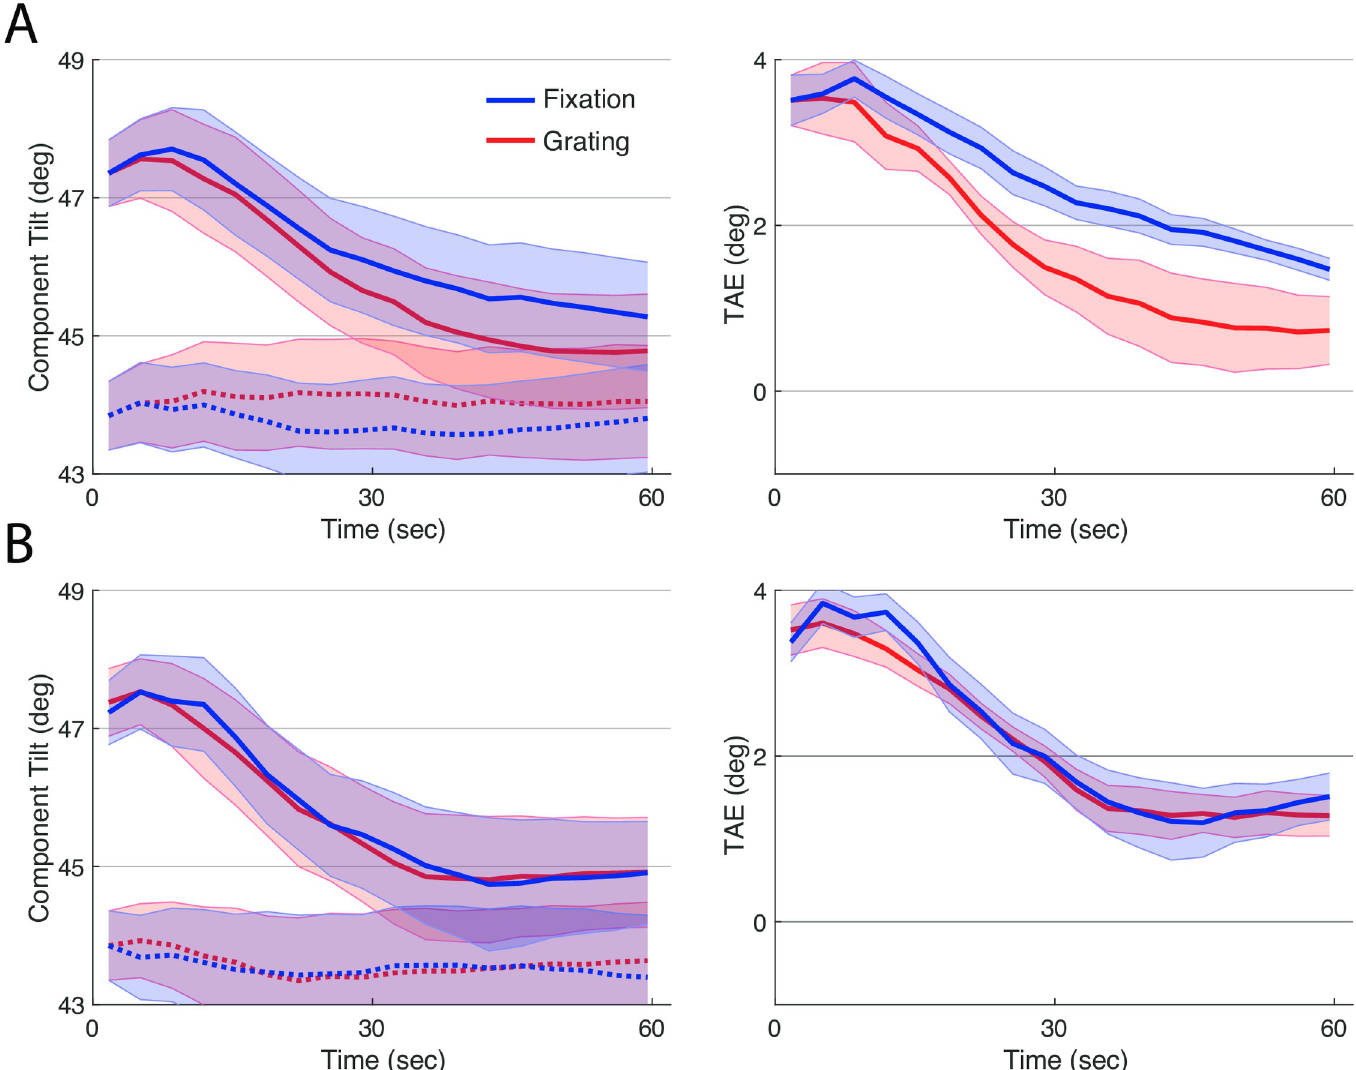
Fig 8. Results of experiment 2 divided by session. The top and bottom panels show results for the first and second session, respectively. Plotting conventions are as in Fig 7.